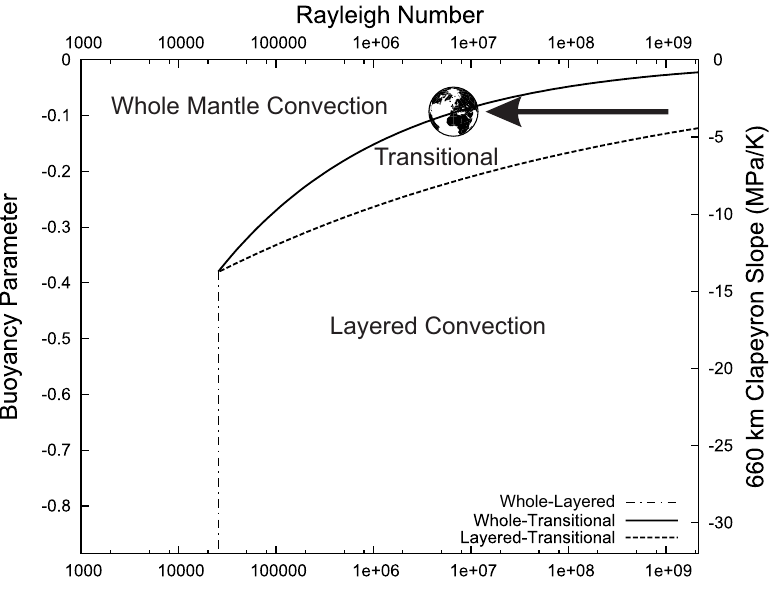
Fig. 5. The figure of Earth represents an estimate of where the present-day Earth might fit on a Rayleigh number versus Buoyancy Parameter plot. The lines mark the boundaries between the 3 regimes found in this work. The arrow shows an approximate potential mantle evolution route through the parameter space over Earth